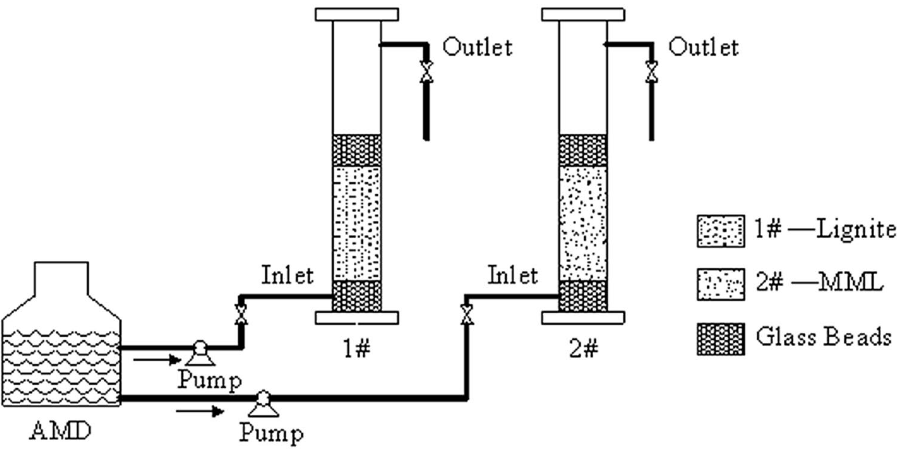
Figure 10. Dynamic test running device